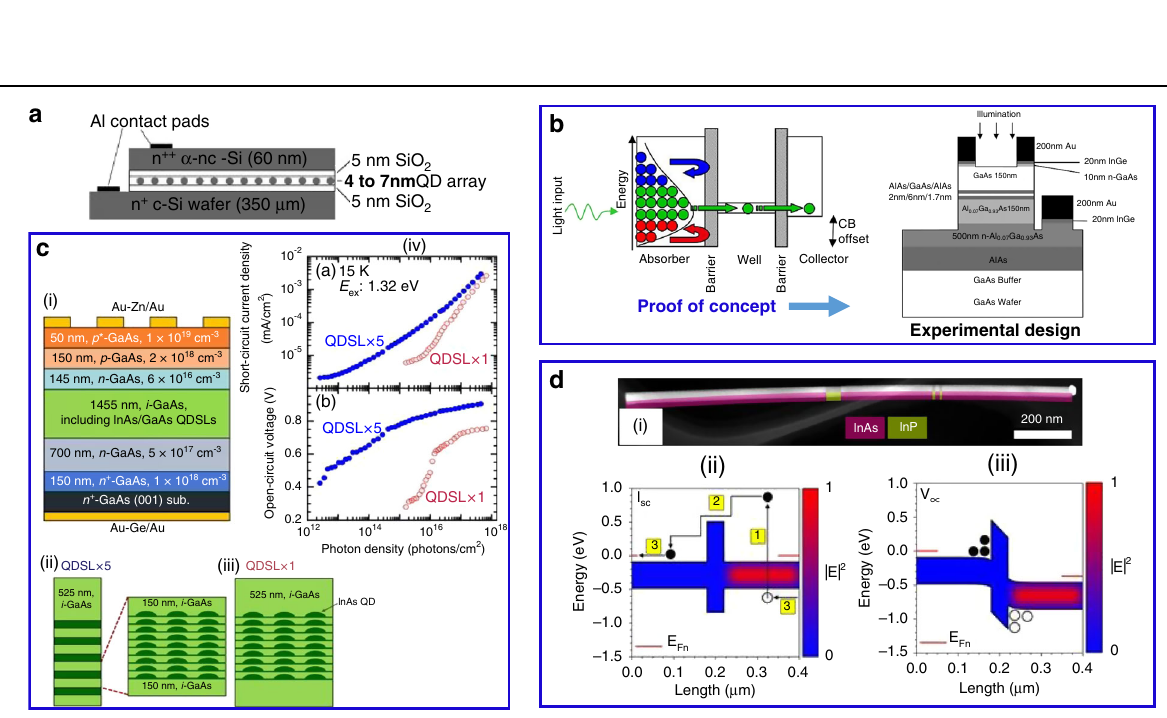
Fig. 13 The schematics and device architecture for HC extraction through energy-selective contacts in various semiconductors. a 2 – 4 nm Si quantum dots are sandwiched between SiO 2 layers. b Hot electrons resonant tunneling concept where the hot electrons with resonant tunneling energy easily cross the barrier while those with non-resonant energy re fl ect back to the absorber. The concept was experimentally proven with GaAs as the absorber and AlGaAs as the hot-electron collector. c InAs/GaAs layered based quantum dot solar cells: (i) the schematics of stacking InAs/GaAs quantum dot layers, (ii and iii) the InAs QD layers are embedded in a GaAs matrix, (iv) stacking multiple QD layers enhances both current and voltage of the device, and d a single nanowire-based HC solar cell: (i) the device cross-section taken with the scanning electron microscope (SEM), (ii) energy band diagram showing three steps in the current generation (I SC ) process as electron – hole pair photo-generation, their diffusion and charge transfer and, (iii) the energy band diagram under V OC condition. The fi gures are taken with permission from ( a ) ref. 73 , ( b ) ref. 78 , ( c ) ref. 71 , and ( d ) ref.